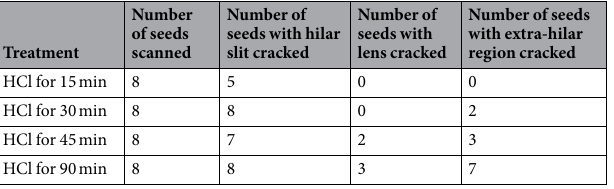
Table 1. Structural changes in dormancy broken Astragalus adsurgens seeds examined under scanning electron microscope after different durations in HCl.